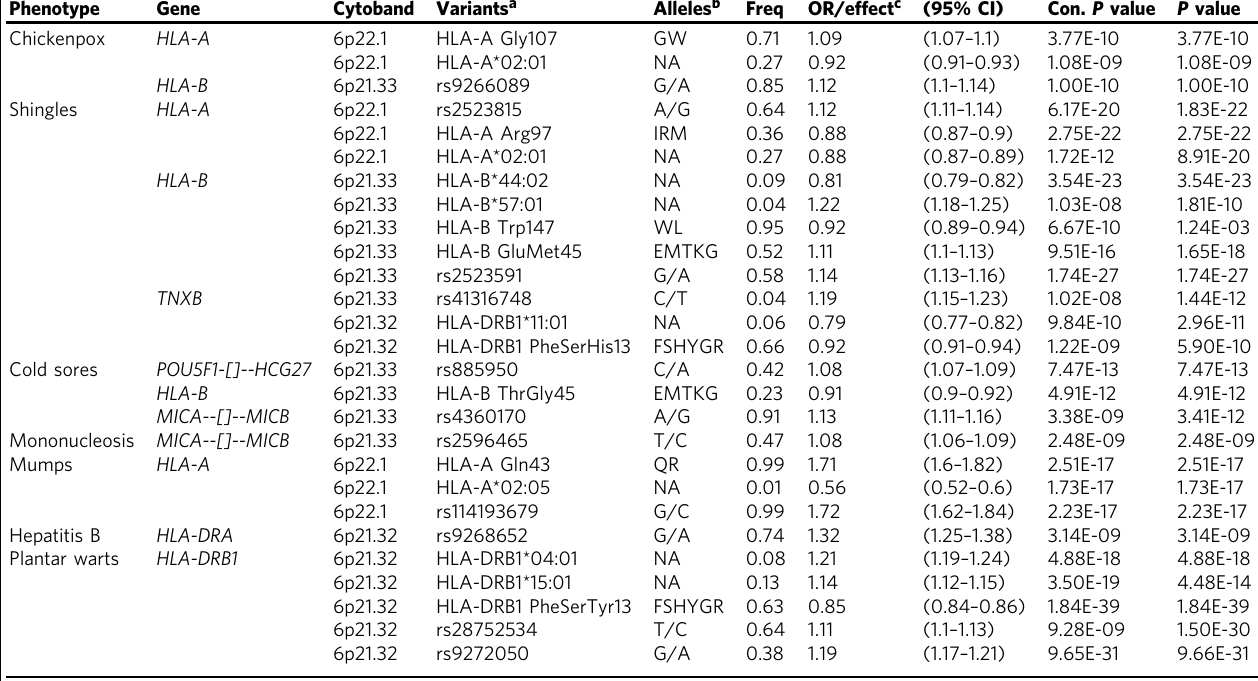
Table 4 HLA fi ne-mapping results for each disease part